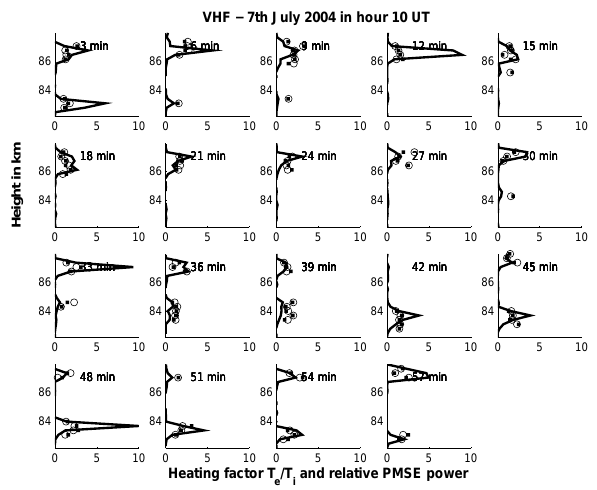
Fig. 10. As in Fig. 8, but now for the hour 10:00 UT on 7 July